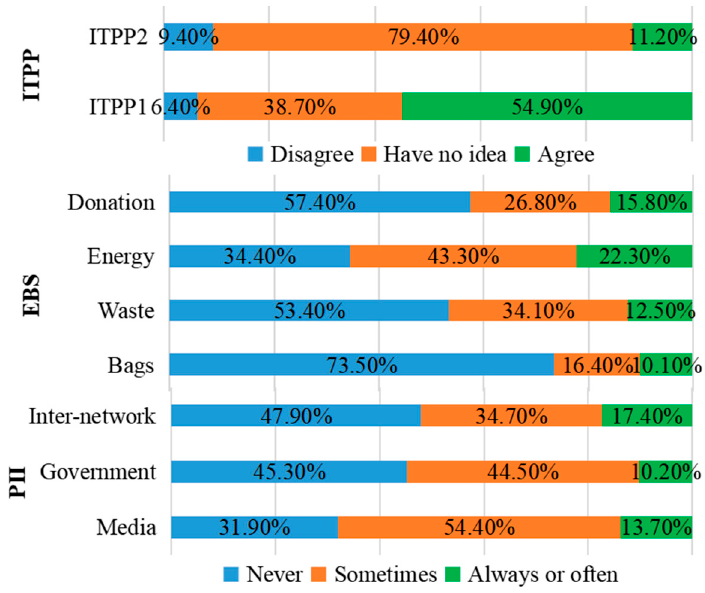
Figure 4. Descriptive information of observable variables.